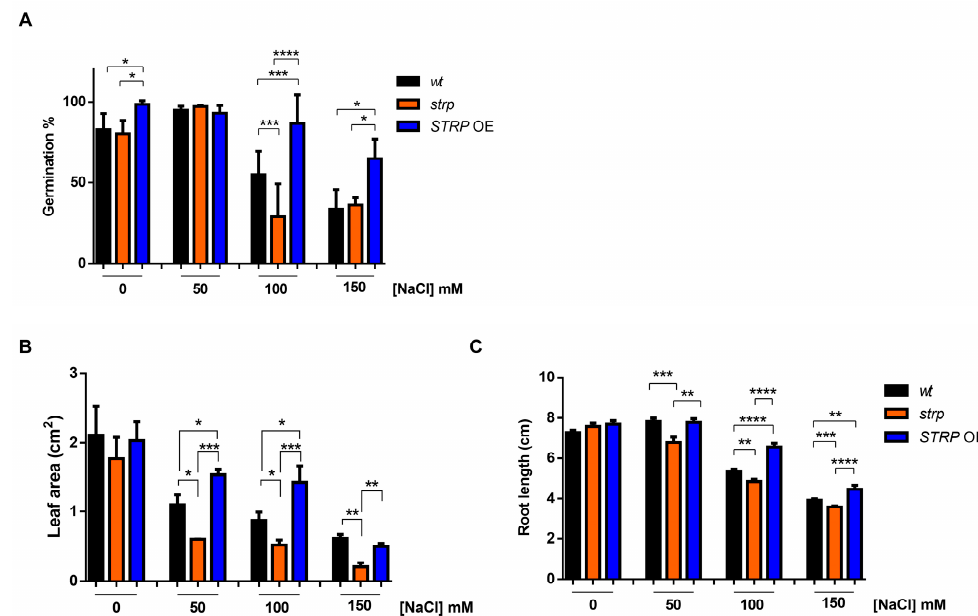
Figure 3. Salt stress affects seed germination, root elongation, and leaf area in strp and STRP OE plants. ( A ) Germination rate was determined on 200 A. thaliana wt , strp, and STRP OE seeds sowed on Murashige and Skoog (MS) supplemented with 50, 100, and 150 mM NaCl. The seeds’ germination rate was assessed after one week. ( B ) for leaf area measurement and ( C ) primary root elongation, wt , strp, and STRP OE plants were grown for four days on MS medium and then transferred on the same medium supplemented with 50, 100, and 150 mM NaCl. After one-week, leaf area and primary root elongation were measured by analyzing digital pictures with the Easy Leaf Area and ImageJ software, respectively. Error bars are s.e.m. of three independent experiments. * p < 0.05, ** p < 0.01, *** p < 0.001, **** p < 0.0001, by Student’s t -test.